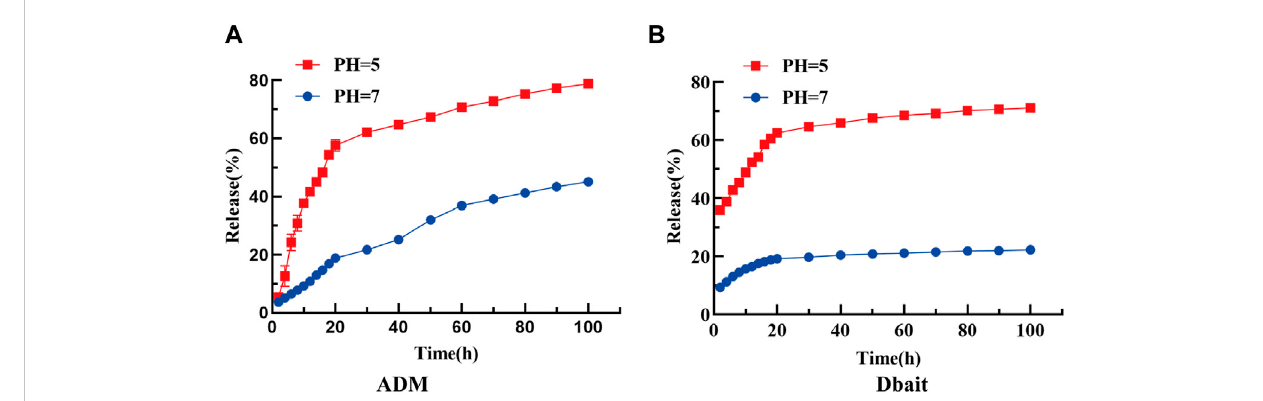
FIGURE 3 Cumulative release rates of (A) ADM and (B) Dbait in PBS at pH = 5,